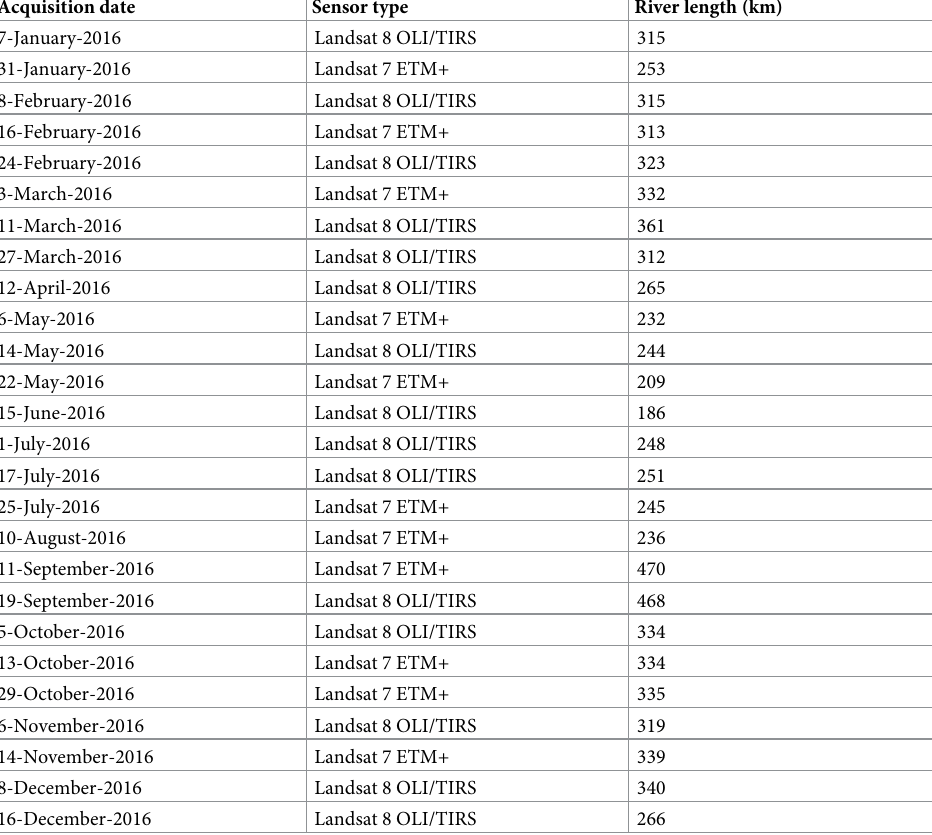
Table 3. Data information of Landsat imagery used and the results of river length in